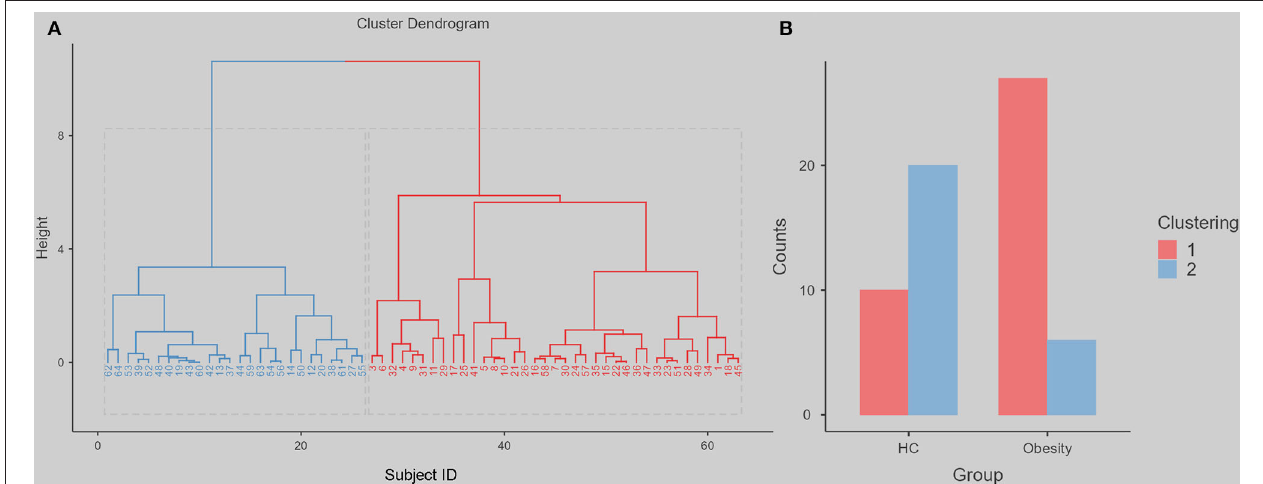
FIGURE 3 | The hierarchical clustering dendrogram and following difference between obesity group and HC. We use the height 8, can divide all the participants into two clustering. The red represents clustering 1, the blue represents clustering 2. (A) The Cluster Dendrogram. (B) The Group Counts for each